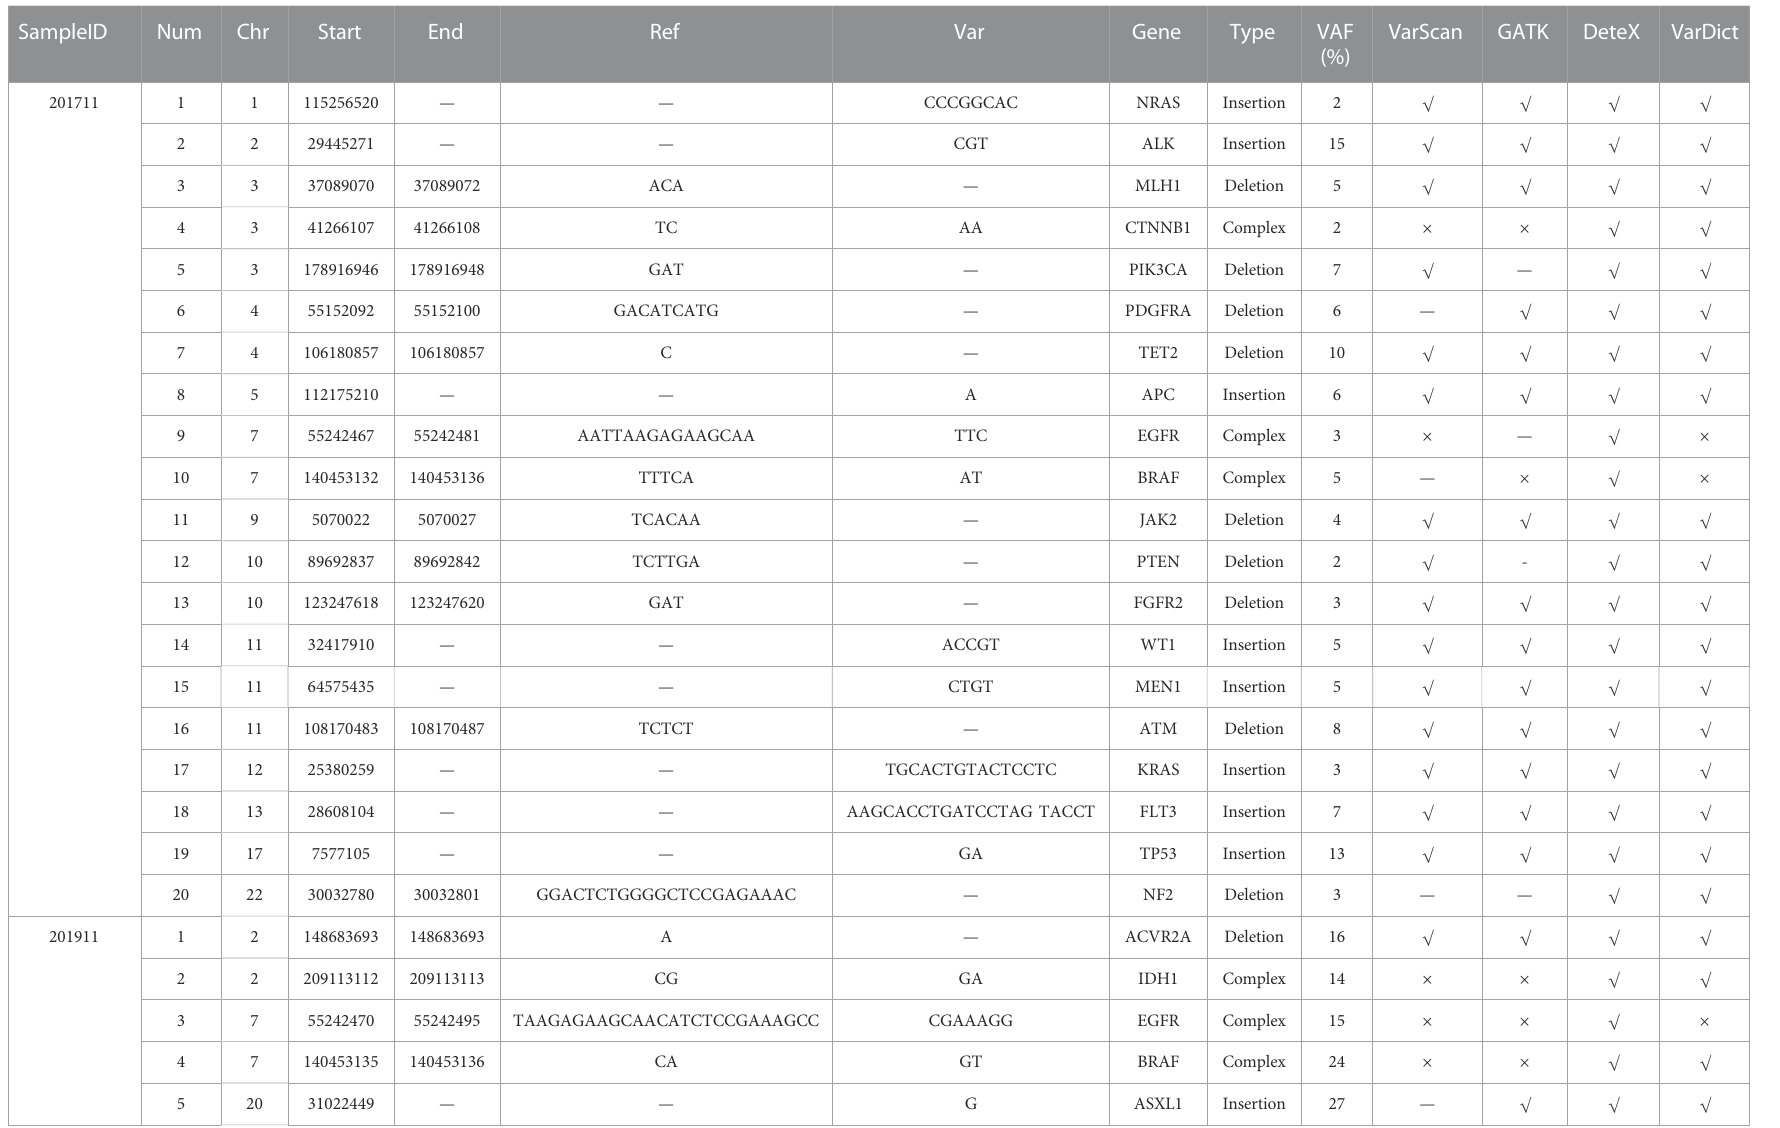
√ ’ indicates a correct result, “ - ” indicates no result, and “ × ” indicates part of